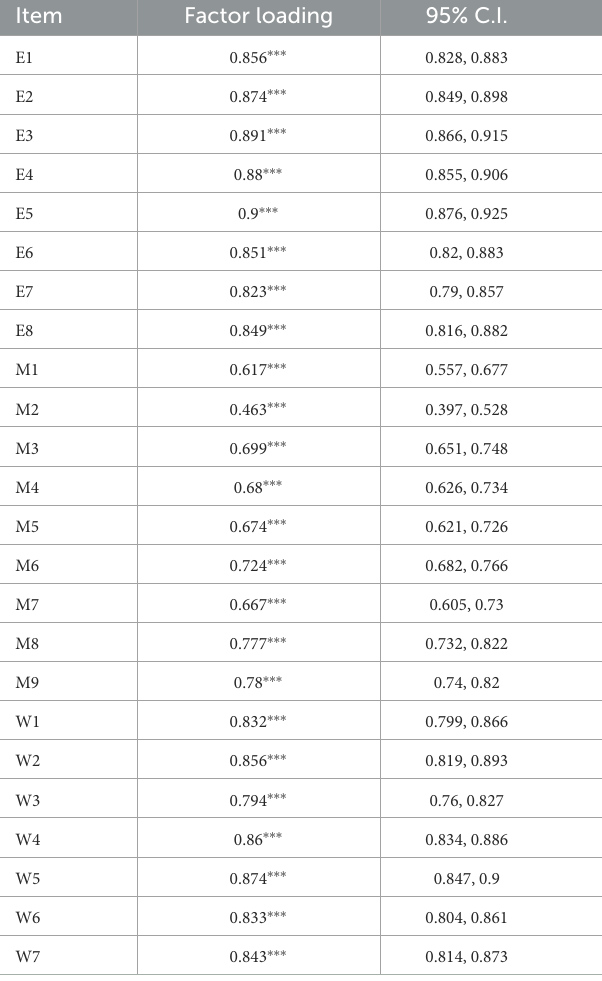
TABLE 3 Factor loadings of three